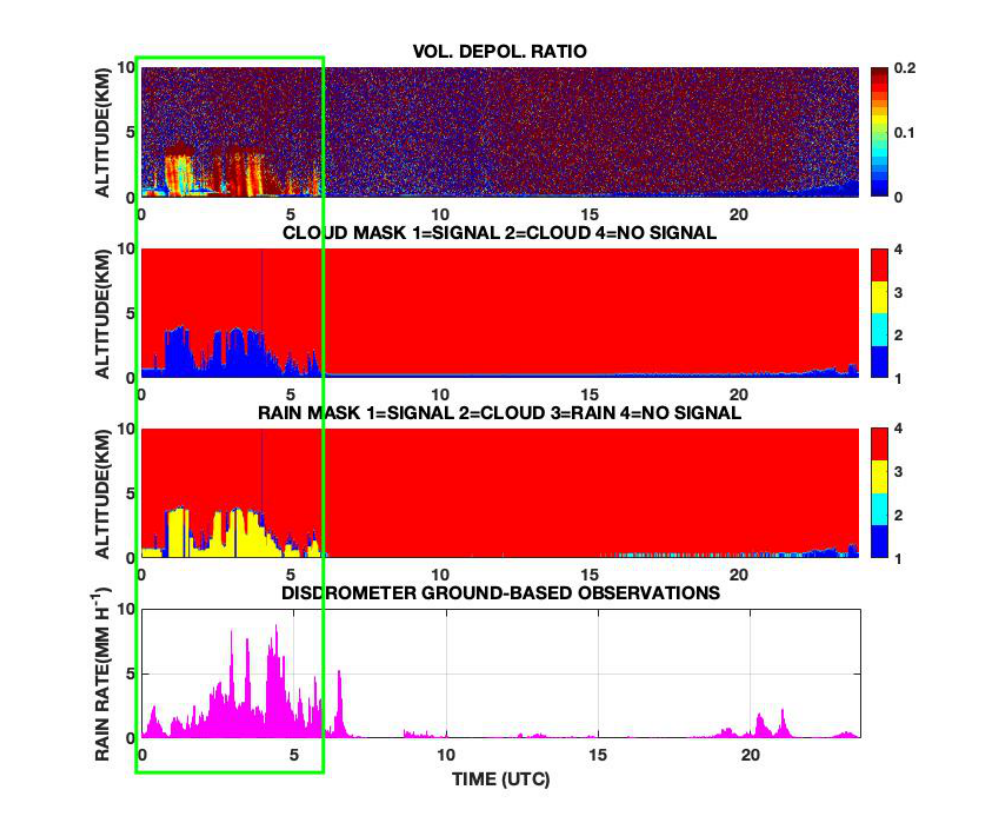
Figure 7. Same as Figure 6, but for 10 November 2015. After 0600 UTC, the signal is completely extinguished making any detection